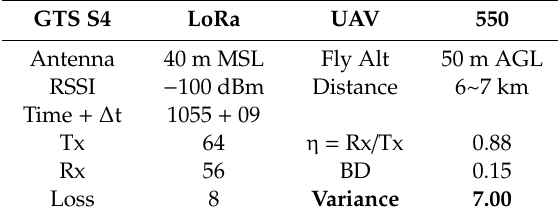
Table 4. Test data at Yen-Sui (S4).